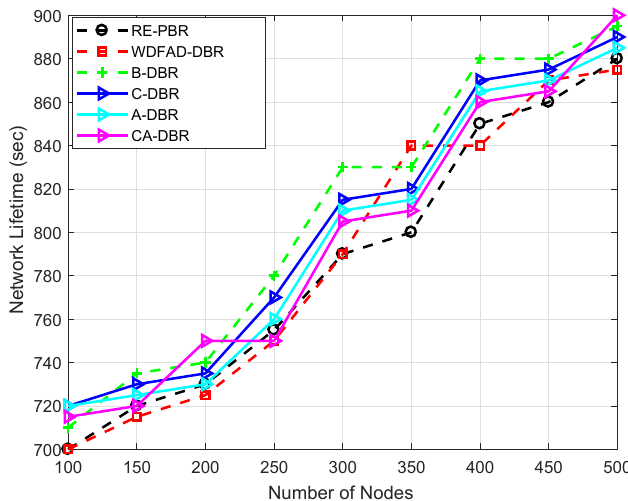
Figure 12. Comparison of network